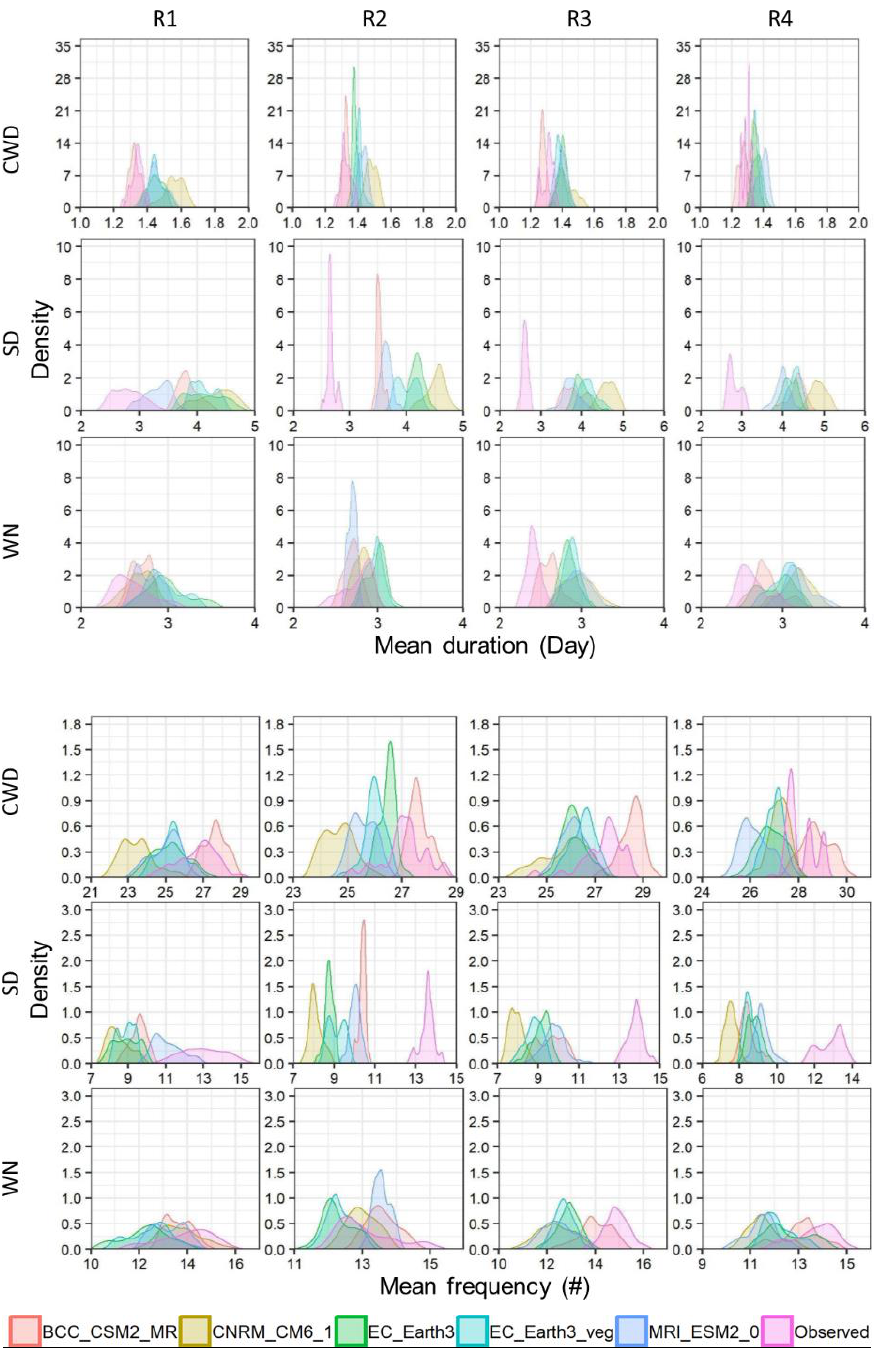
Figure 9. Kernel density curves of mean duration and mean frequency of CWD, SD, and WN corresponding to four climate regions in Alberta for the 1983–2014